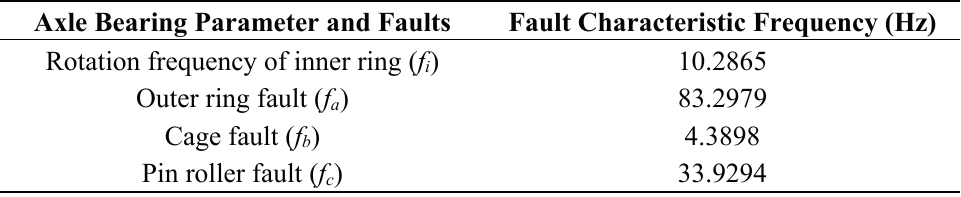
Table 1. Axle bearing characteristic frequencies at a wheel experiment speed of 100